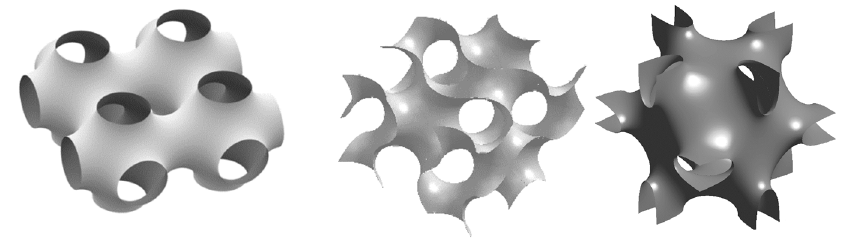
Figure 15. A selection of triply periodic minimal surfaces, left to right: the Schwarz P Surface, the Gyroid and the Neovius’ surface (Attr, in order: Anders Sandberg, Catsquisher, Anders Sandberg, Wikimedia Commons).